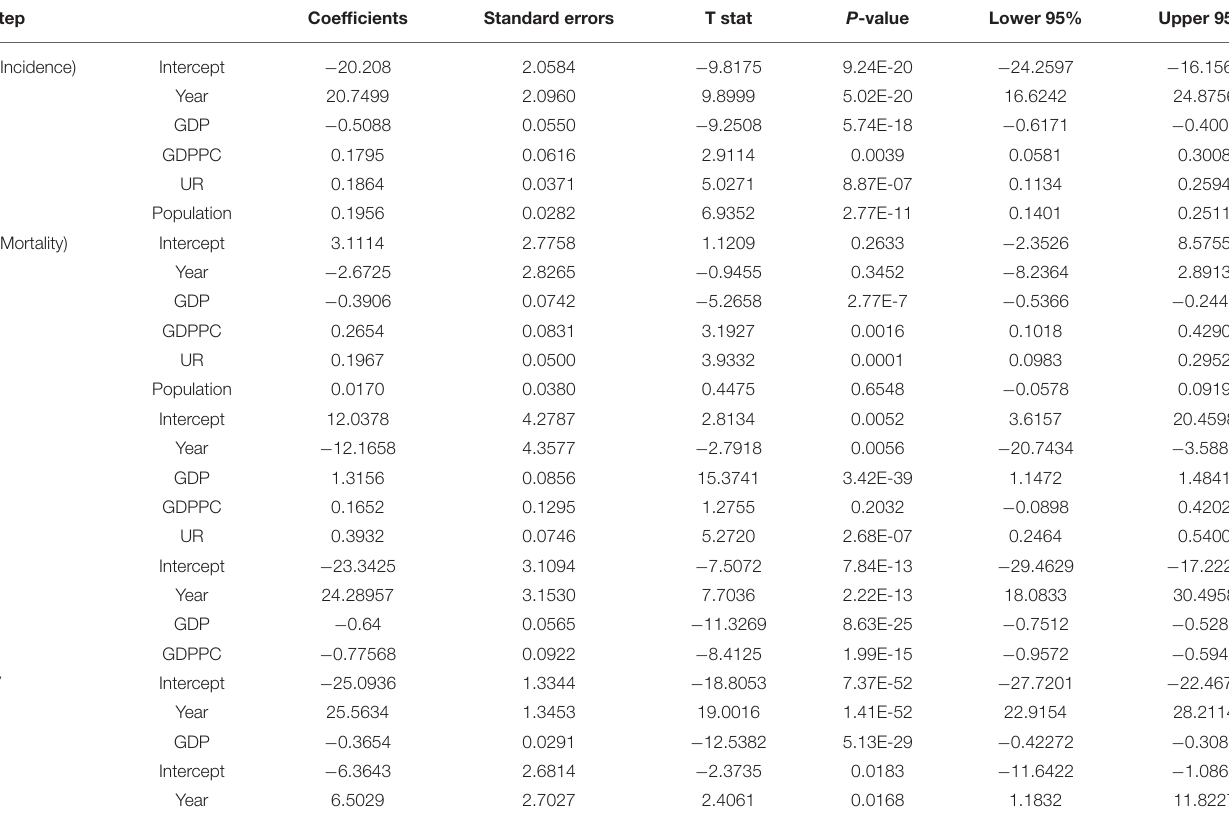
TABLE 2 | A structural equations model based on the regression analysis of the incidence and mortality rates of female breast